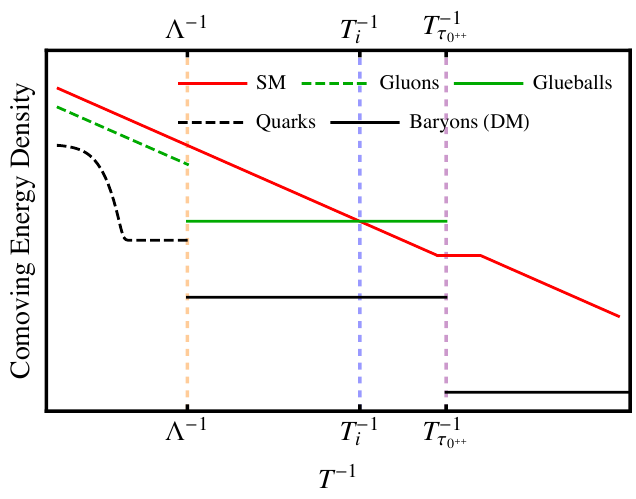
Figure 1 . The schematic evolution of different relics abundances in our setup. We show the schematic contours for SM (red — neglecting changes in number of relativistic degrees of freedom), dark quarks and dark baryons (dashed and solid black lines), and dark gluons and glueballs (dashed and solid green lines). The PT epoch is marked by the dashed orange line. We have assumed the glueballs are long-lived enough that they take over the energy budget of the universe at some point (marked by the dashed blue line) and eventually decay to the SM at a lower temperature (dashed purple line). As a result, they inject significant amount of entropy into the SM bath that further suppresses the dark baryons abundance. Due to this injection, SM comoving abundance dilutes more slowly during this